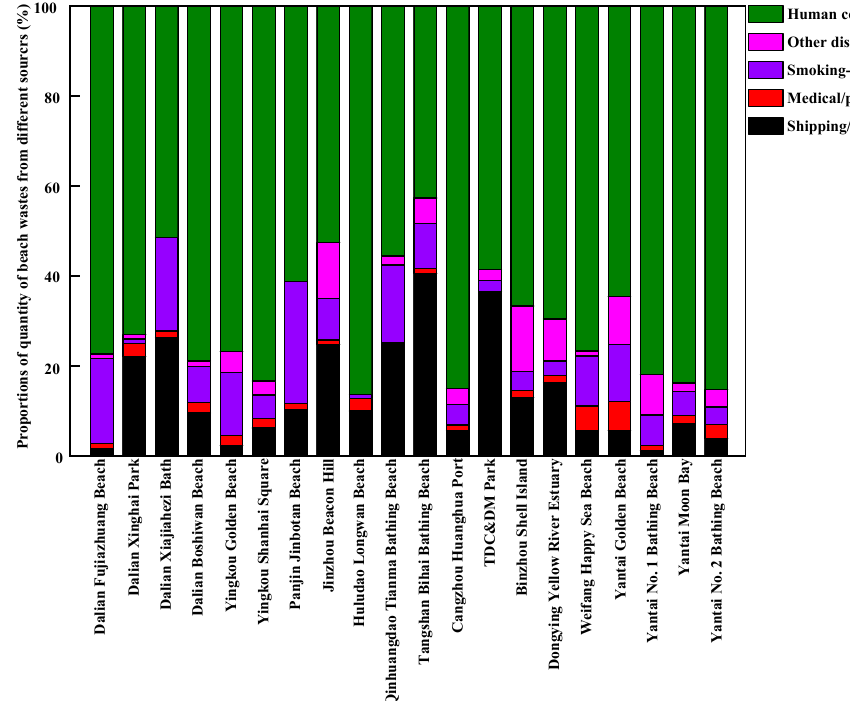
Figure 9. The proportions of beach waste from different sources in coastal cities around the Bohai Sea of China in the tourist peak season, by quantity.